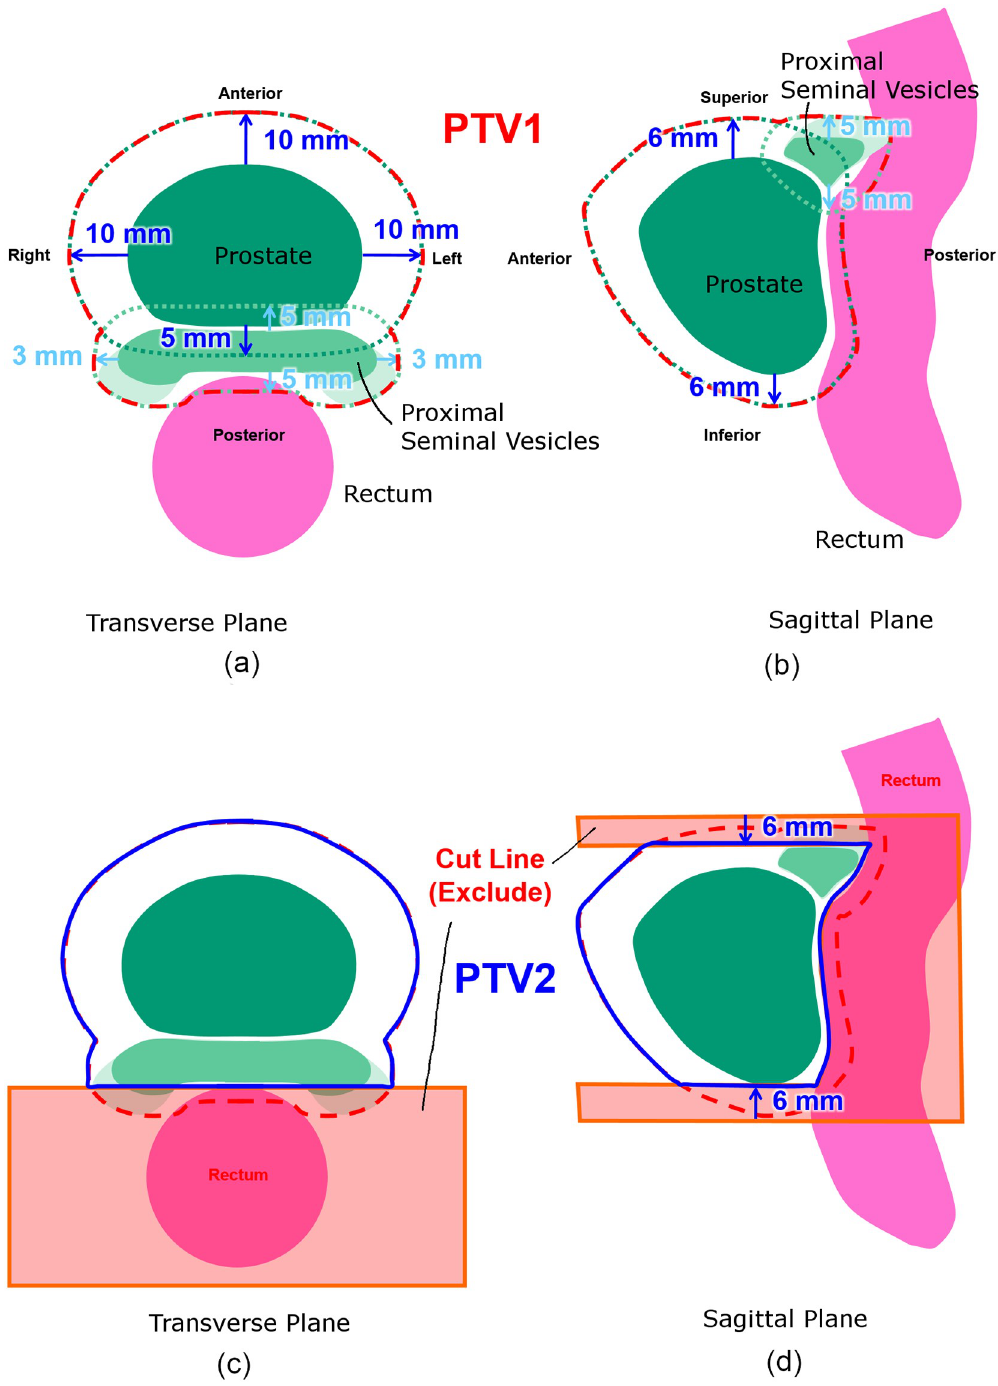
Fig 2. Schematic showing (a,b) PTV1 and (c,d) PTV2 for 16-fraction prostate CIRT at the GHMC. Image revised with permission from the GHMC treatment guidelines.